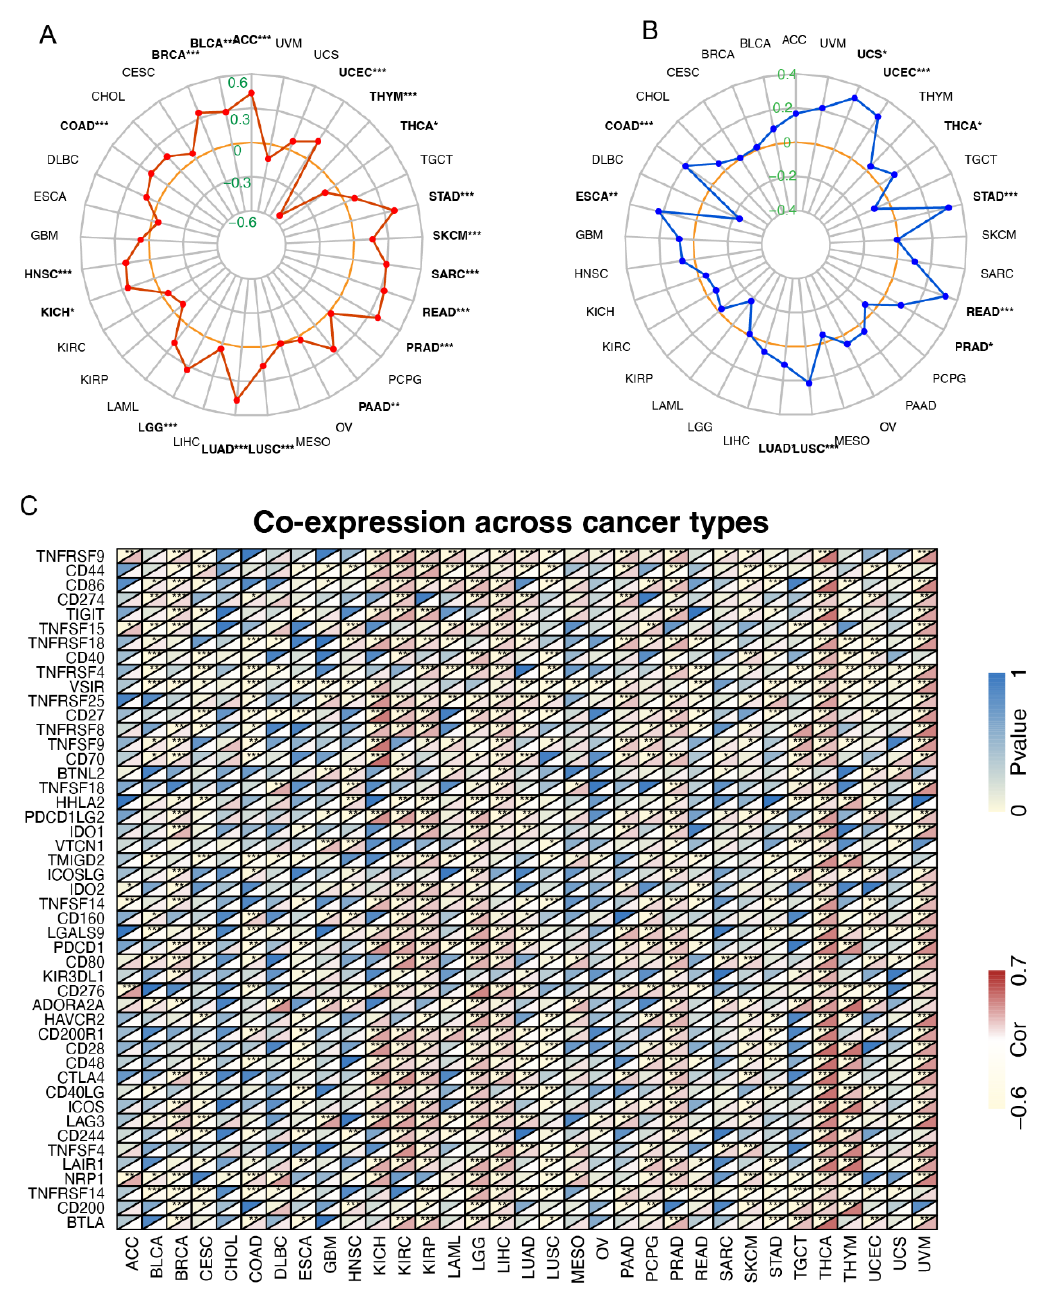
Figure 5. Correlation between the expression of FAM72A with tumor mutation burden (TMB), microsatellite instability (MSI), and immune checkpoint genes in pan-cancer. A-B. Radar maps showing the correlation of the expression of FAM72A with TMB ( A ) and MSI ( B ) by radargrams in pan-cancer. ( C ). Heatmap for the correlation of the expression of FAM72A with immune genes by heatmap in pan-cancer. The Spearman method was used to estimate the correlations. * p < 0.05, ** p < 0.01 and *** p < 0.001.